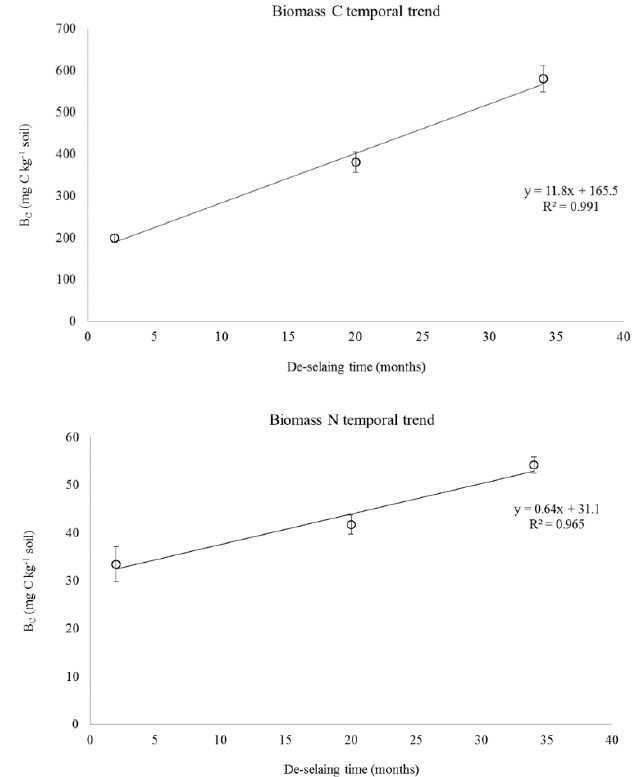
Figure 2. Trend of the microbial biomass C in soil de-sealed for 2, 20 and 34 months. The error bar represents the standard deviation of the mean values ( n = 5).